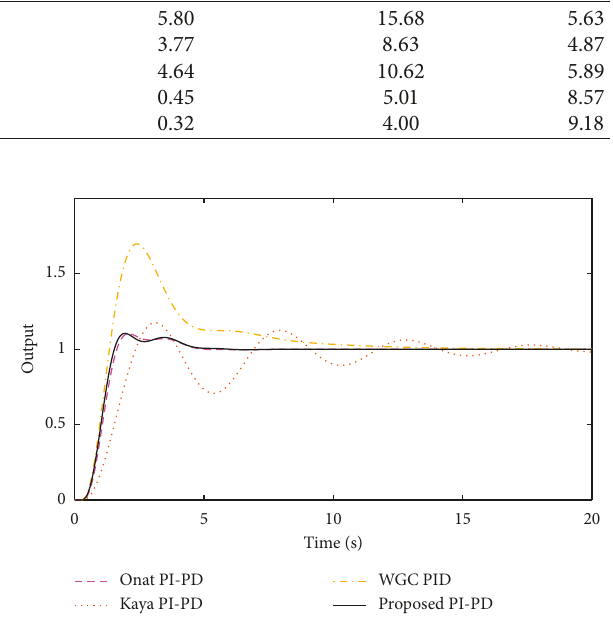
Figure 7: Step responses comparison of various methods for ex- ample